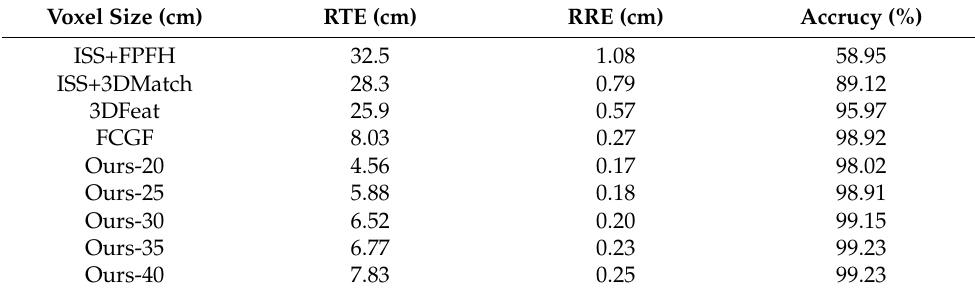
Table 4. The result of KITTI